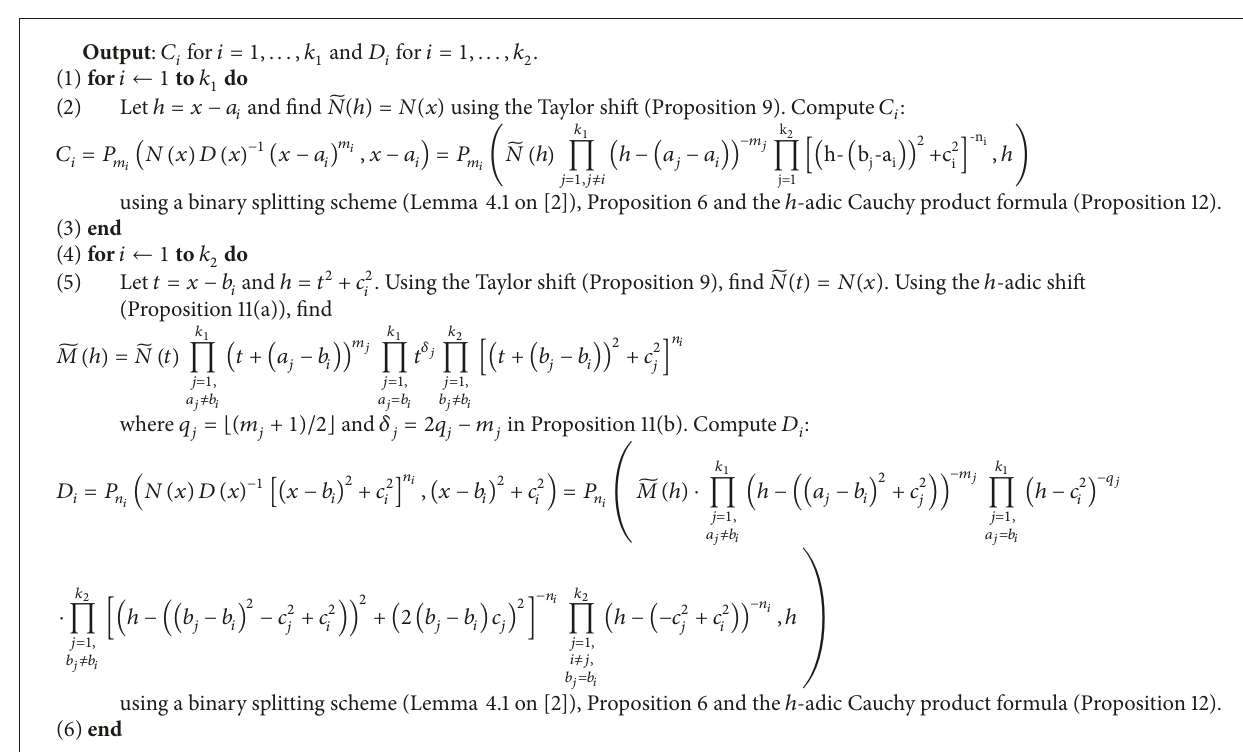
Algorithm 1: Main